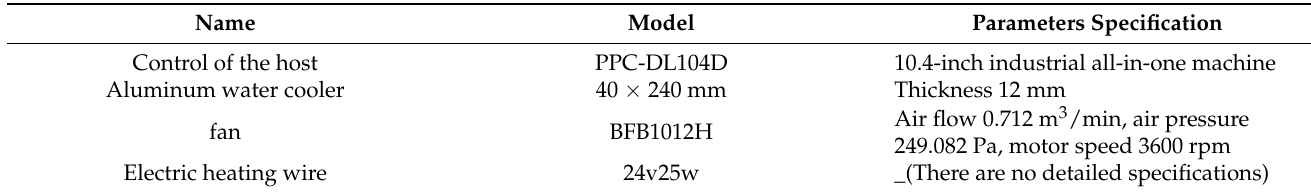
Table 2 lists the specifications, models and parameters of the main components of the system; Table 3 lists the measurement parameters and detection components. Table 2. Models and parameters of the main components.